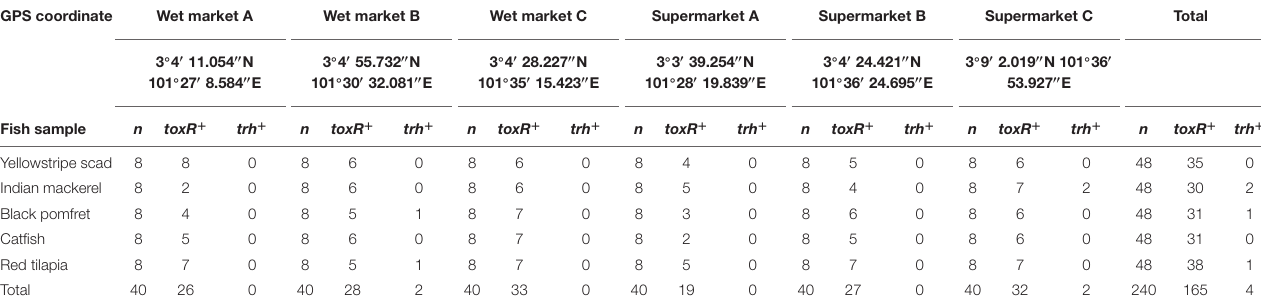
TABLE 1 | The frequency of Vibrio parahaemolyticus detected in different fish samples from different sampling locations by using PCR assay. GPS coordinate Wet market A Wet market B Wet market C